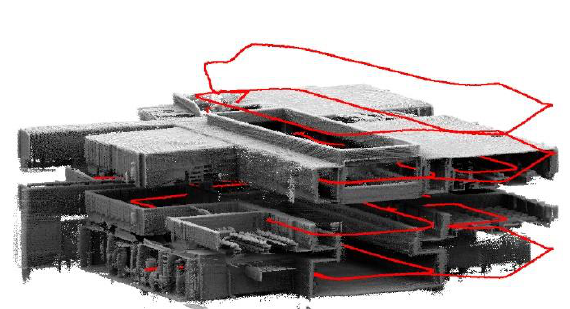
Figure 12. Indoor positioning reference example. The red line is the reference trajectory from SLAM process. The point cloud map generated based on the red trajectory is a five-floors building. (Only part of the building is shown).